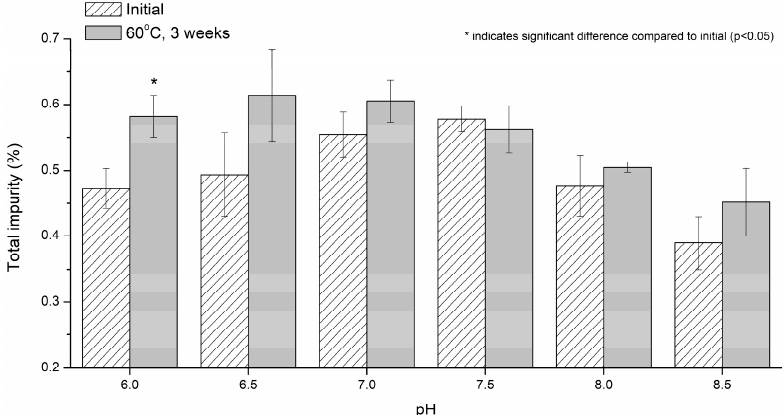
Figure 6. Effect of pH on the pemetrexed degradation induced by stress condition at 60 °C in aqueous solution. * indicate significant difference compared to inital ( p < 0.05).